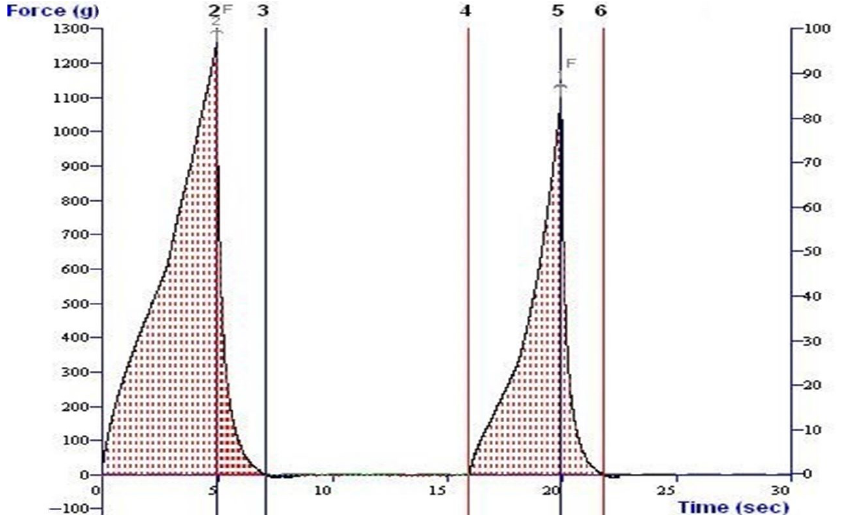
Figure 2. Typical Force ‐ Time curve from one of the samples for texture profile analysis of date palm cv. Sukary. Table 4 . Effects of irrigation levels, SOP fertilizer doses, and bunch thinning levels on the hardness, springiness, cohesiveness, gumminess, chewiness, and resilience of date palm cv. Sukary. Each mean data represents the averages from two seasons, 2020/2021 – 2021/2022.